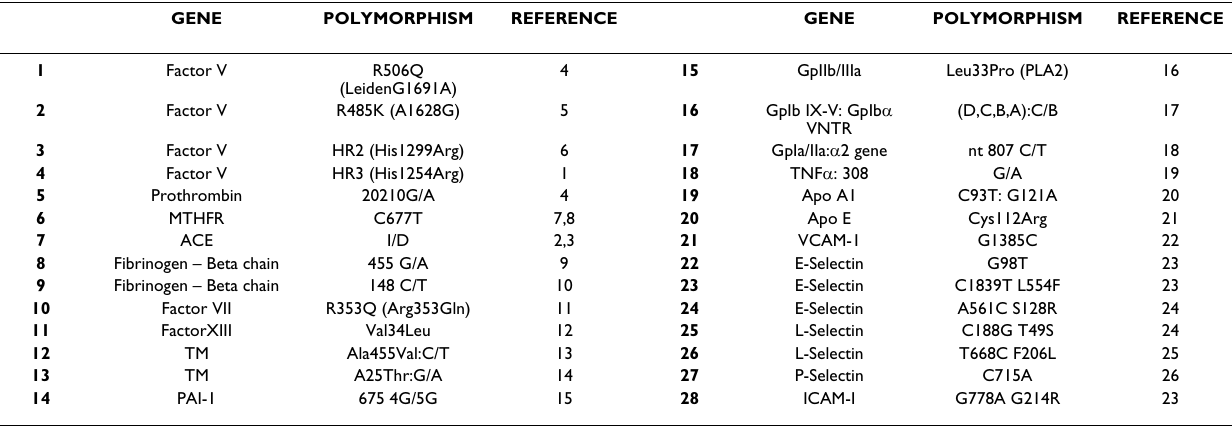
Table 1: List of 28 polymorphisms in 20 candidate genes used in this study